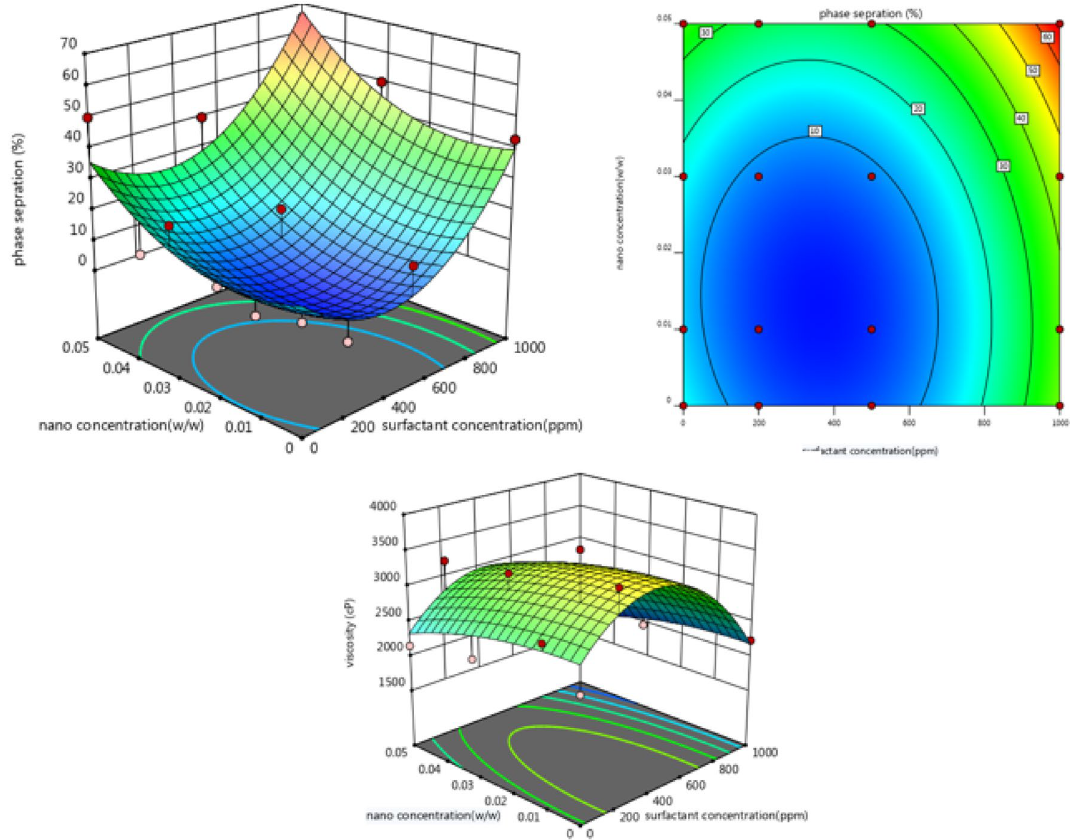
Figure 9. Effect of nanoparticle and surfactant concentration on viscosity and phase separation after 30 days (3D and contour plots).